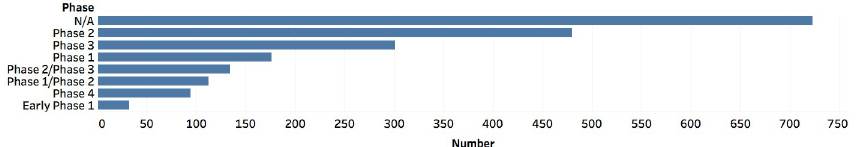
Fig 5. Phase information including phase 0, the FDA defines a five phase process for approving new drugs [14]. This graph shows the phases for COVID-19 related clinical trials.